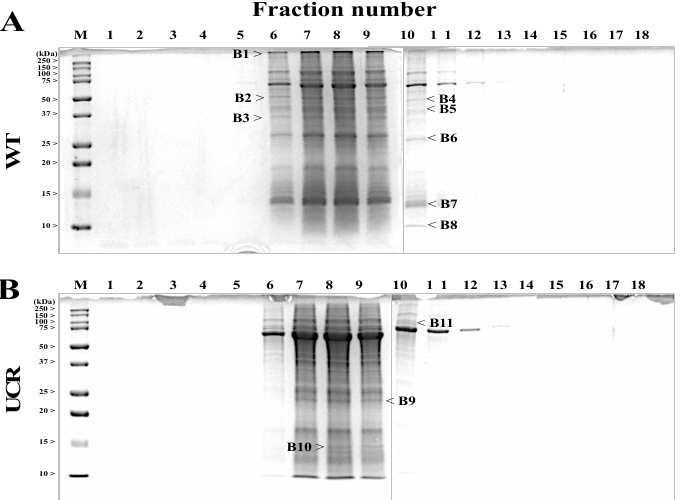
Figure 3. Fractionation and separation of rectal proteins in WT and UCR. The rectal proteins of WT and UCR were fractionated using gel filtration columns. The protocol is described in Section 2.7 in detail. Panels ( A , B ) show protein bands separated by SDS-PAGE from each fraction of WT and UCR, respectively (Figures S1 and S2). Lane M is the molecular weight markers, and lanes 1 to 18 are the eighteen fractions after gel filtration chromatography. The protein bands of B1 to B11 (black arrows, > or <) were selected and subjected to mass spectrometry (MALDI-TOF). WT: Wild type Slc:Wistar rats; UCR: Slc:Wistar rats treated with 5% dextran sulfate sodium.